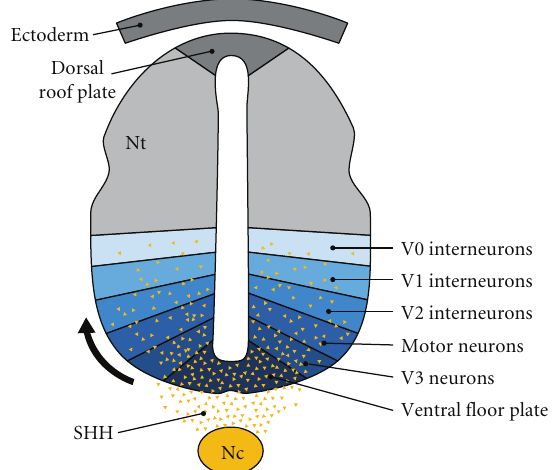
Figure 2: The sonic hedgehog gradient in embryonic neural patterning . SHH-regulated gradient defines neuronal subtypes during embryonic patterning. Sonic hedgehog (SHH) (yellow) is secreted from cells of notochord (Nc) and ventral floor plate to create a ventral- dorsal concentration gradient along the neural tube (Nt). Spatial organization of six progenitor-cell domains is established by the SHH gradient restricting the expression of various protein-marker profiles. The initiation of these markers at successive developmental time periods results in V0–V3 and motor neuron (MN) subtype patterning along the ventral midline in the neural